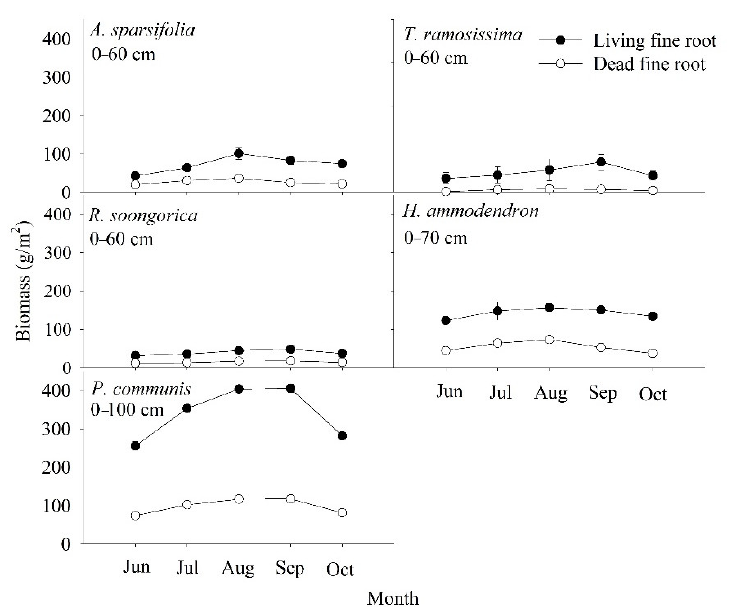
Figure 3. Seasonal living and dead fine root biomass (mean ± SD) of the five plant communities at different soil depths. Each value represents the average of three replicates.